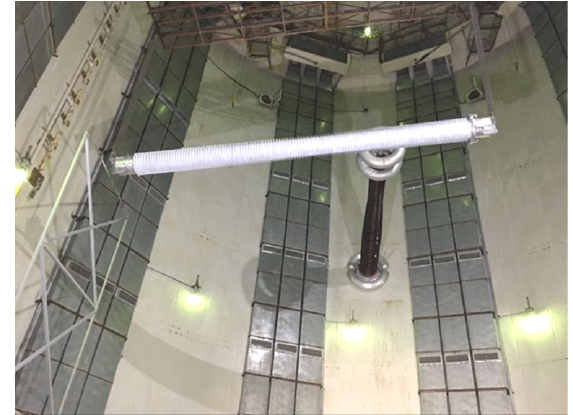
Figure 2. Sample arrangement. Figure 2. Sample Table 1. Composite crossarm insulator parameters.